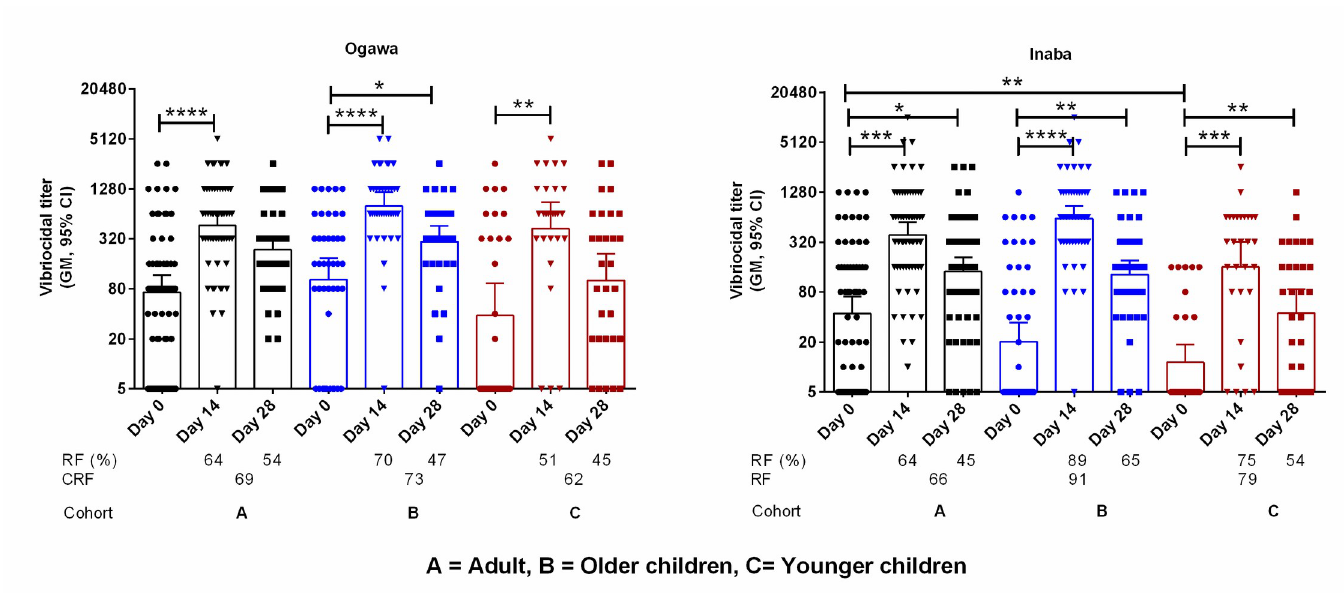
Fig 3. Vibriocidal antibody titer in the plasma of FDMN population to Ogawa and Inaba serotype in adult, older children and younger children. Asterisk denote the level of significance ( � , P < 0.05; �� , P < 0.01; ��� , P < 0.001 and ���� , P < 0.0001. Responder frequency (R/F) was calculated as four-fold rise of antibody titer compared to day 0 and cumulative responder frequency (CRF) calculated from either four-fold increase in any day post immunization (day 14 and day 28).